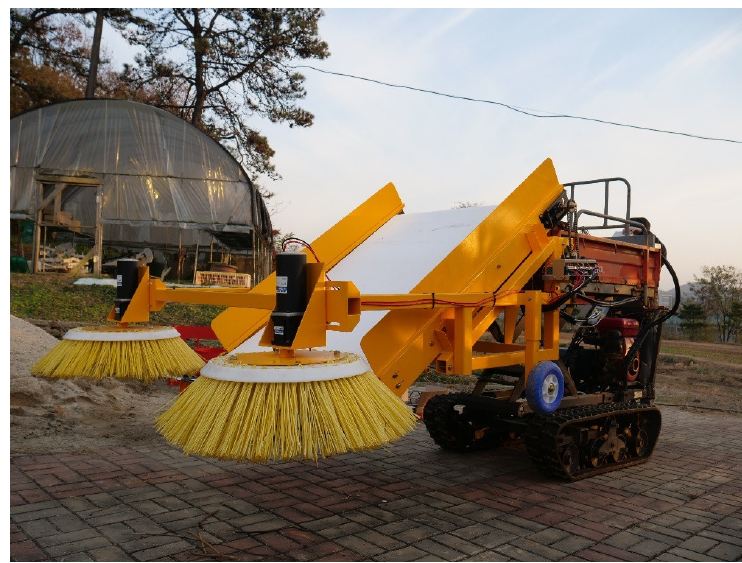
Figure 8. Collecting/transferring part lifted to the highest point.